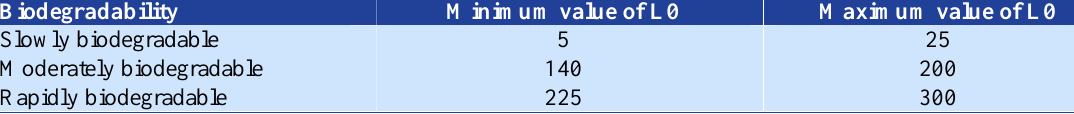
Table 3. Estimation of L0 (m3/ton) based on the waste